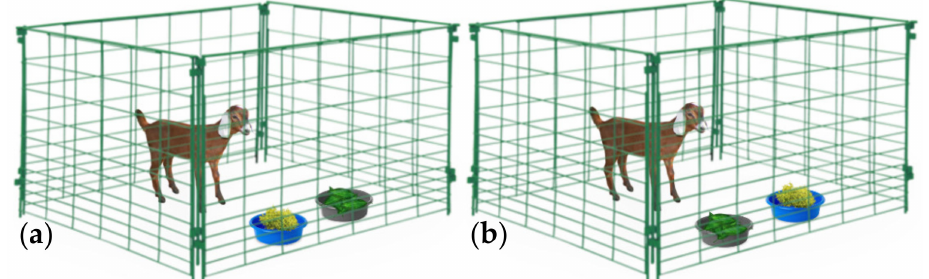
Figure 3. On-station trial for the evaluation of in vivo anthelmintic properties of plants. When a cafeteria trial of two plant species are performed, it is recommended that the candidate for nutraceutical properties contains a known quantity of a plant secondary compound while the other plant does not. ( a , b ) represent the first and second experimental days, respectively. For the establishment of control groups, a polymer (polyethylene glycol) could be used to neutralize condensed tannins and other polyphenols. Activated charcoal could be used to neutralize some terpenes. Containers in which the plants are o ff ered must be equidistant and changed on a daily basis to avoid associate learning. Some researchers choose to hang experimental plants to simulate browsing ingestive behaviors. Such considerations should be in function of the facilities where trials are